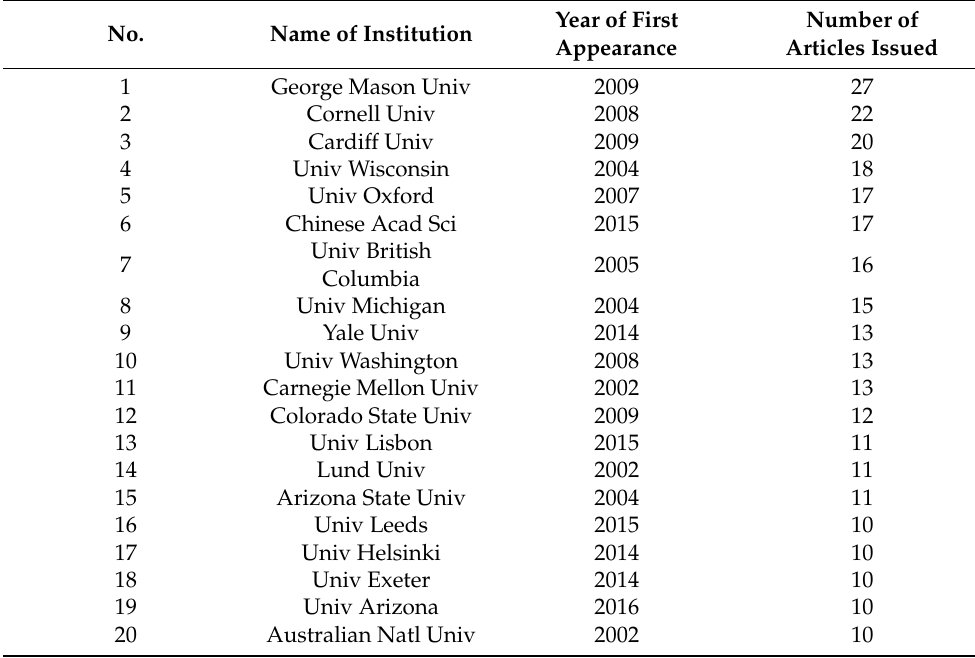
Table 3. Top 20 research institutions with the highest number of published papers. No. Name of Institution